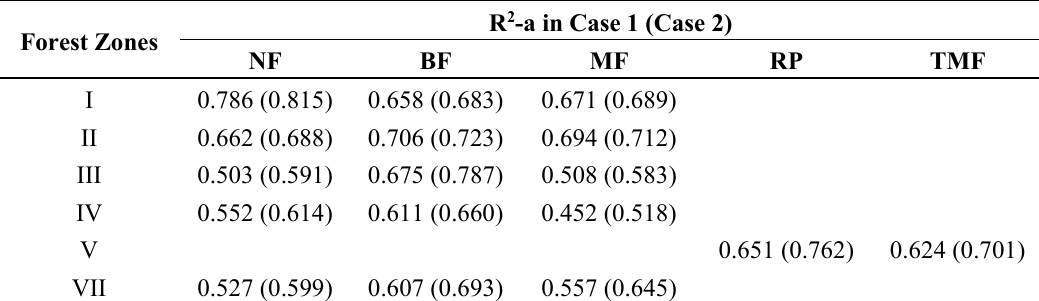
Table 4. R 2 -a (adjusted R-square) of GLAS-based (the Geoscience Laser Altimeter System) AGB (aboveground biomass) models using datasets of case (1) and case (2) in the six forest zones. The first set of numbers in each group corresponds to the R 2 -a of AGB models from GLAS footprints on all slopes (without using lead, trail, and h slope ). The second set of numbers (in round brackets) is R 2 -a values of AGB models from GLAS footprints on all slopes using all GLAS waveform metrics (including lead, trail, and h slope